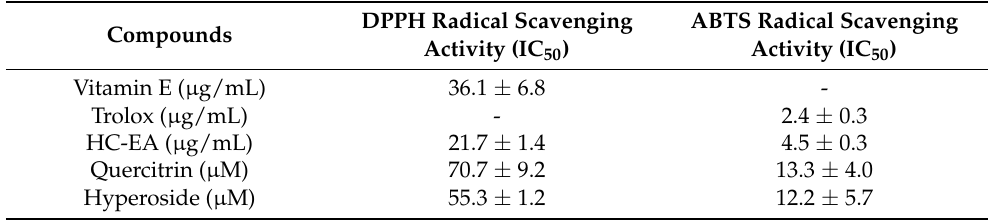
Table 2. ABTS and DPPH free radical activity of the HC-EA and its actives compounds were examined in the present